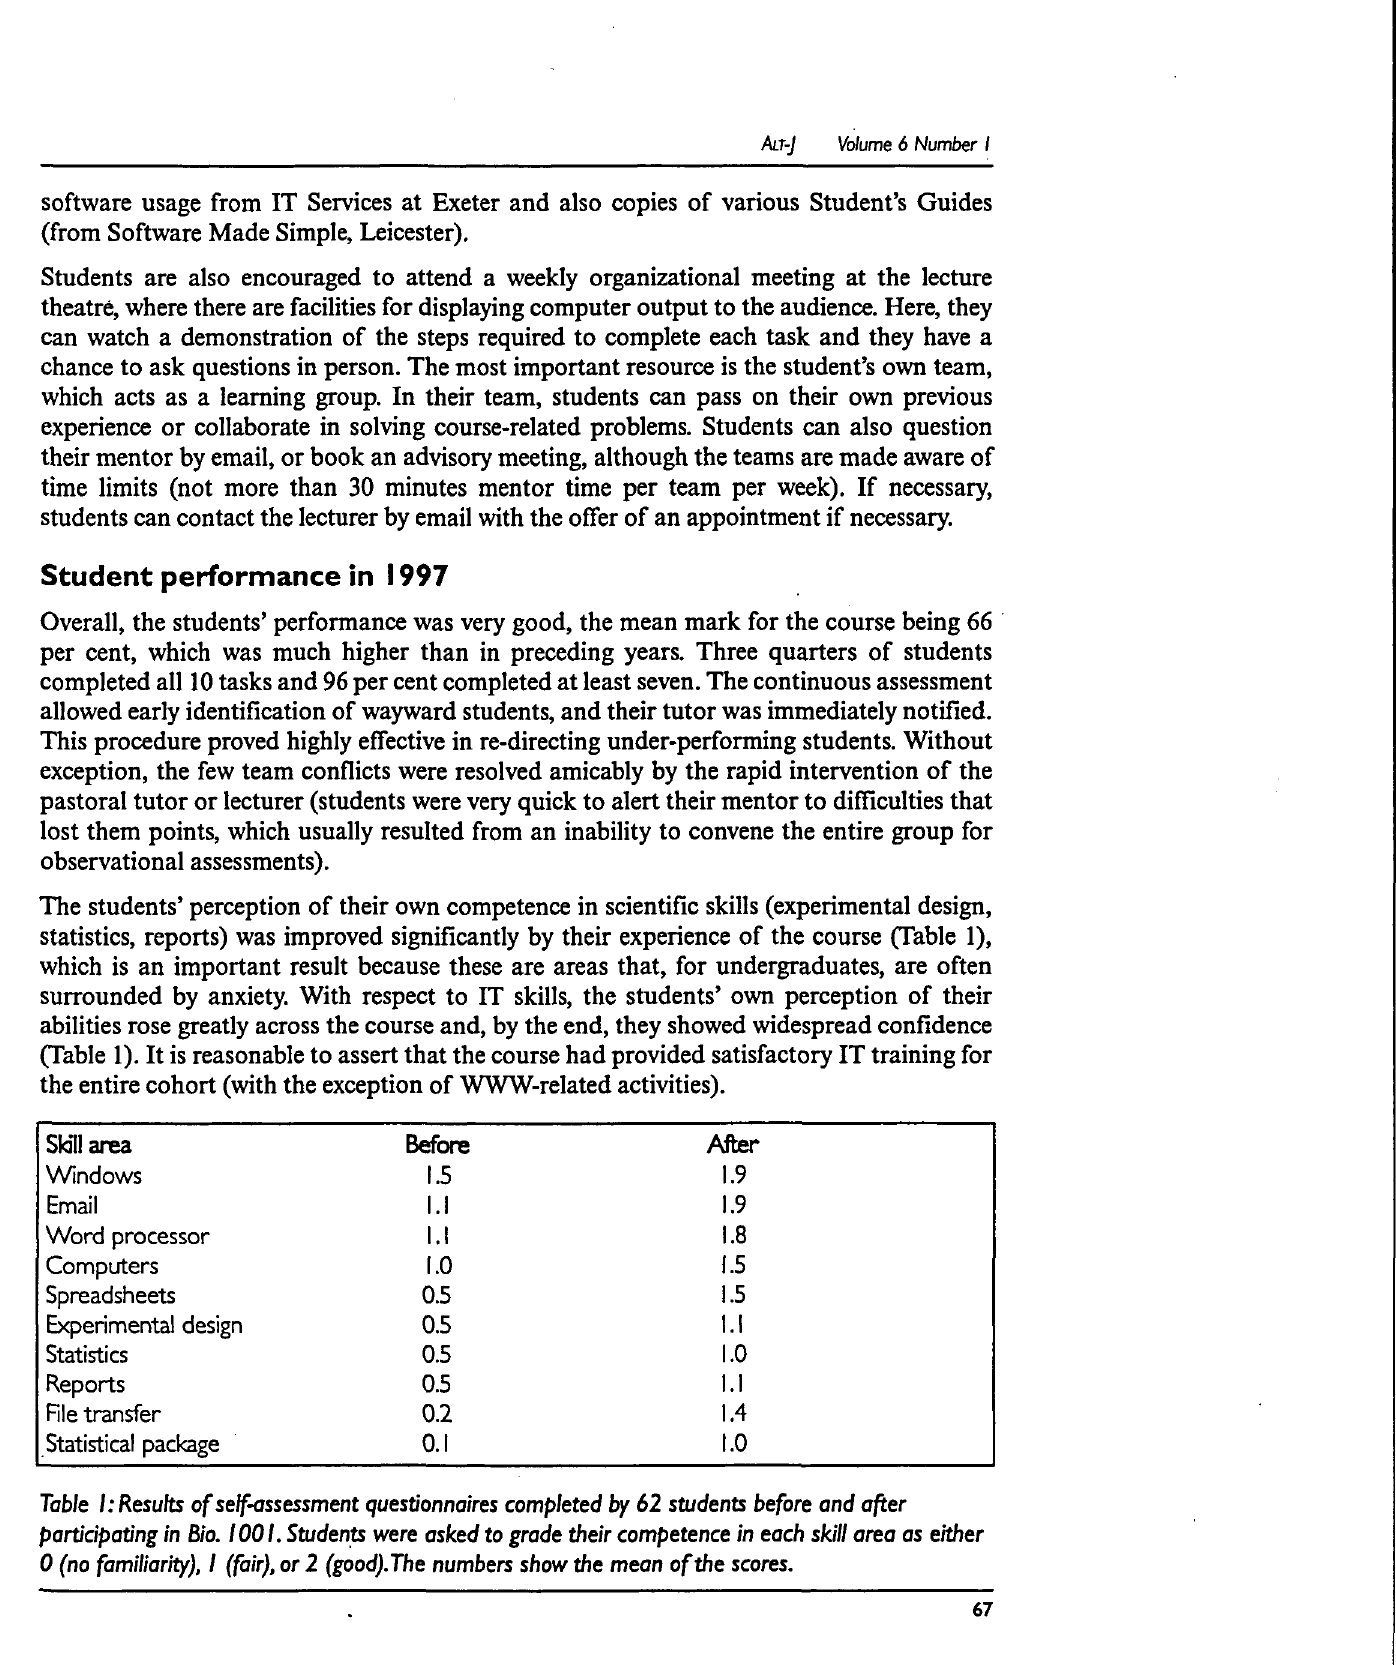
Table I: Results ofself-assessment questionnaires completed by 62 students before and after participating in Bio. 1001. Students were asked to grade their competence in each skill area as either 0 (no familiarity), I (fair), or 2 (good).The numbers show the mean of the